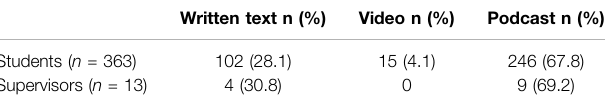
TABLE 3 | The distribution of the answers by students and their supervisors to “ Whichsubmissionformatdoyouthinkprovidesthehighestlearningoutcome in an interprofessional group assignment collaboration? ” Written text n